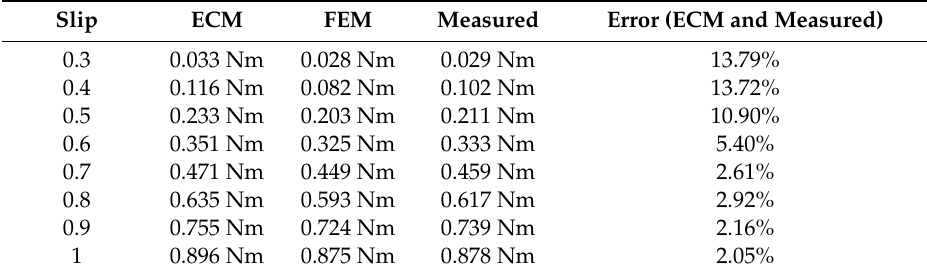
Table 7. Out torque comparison